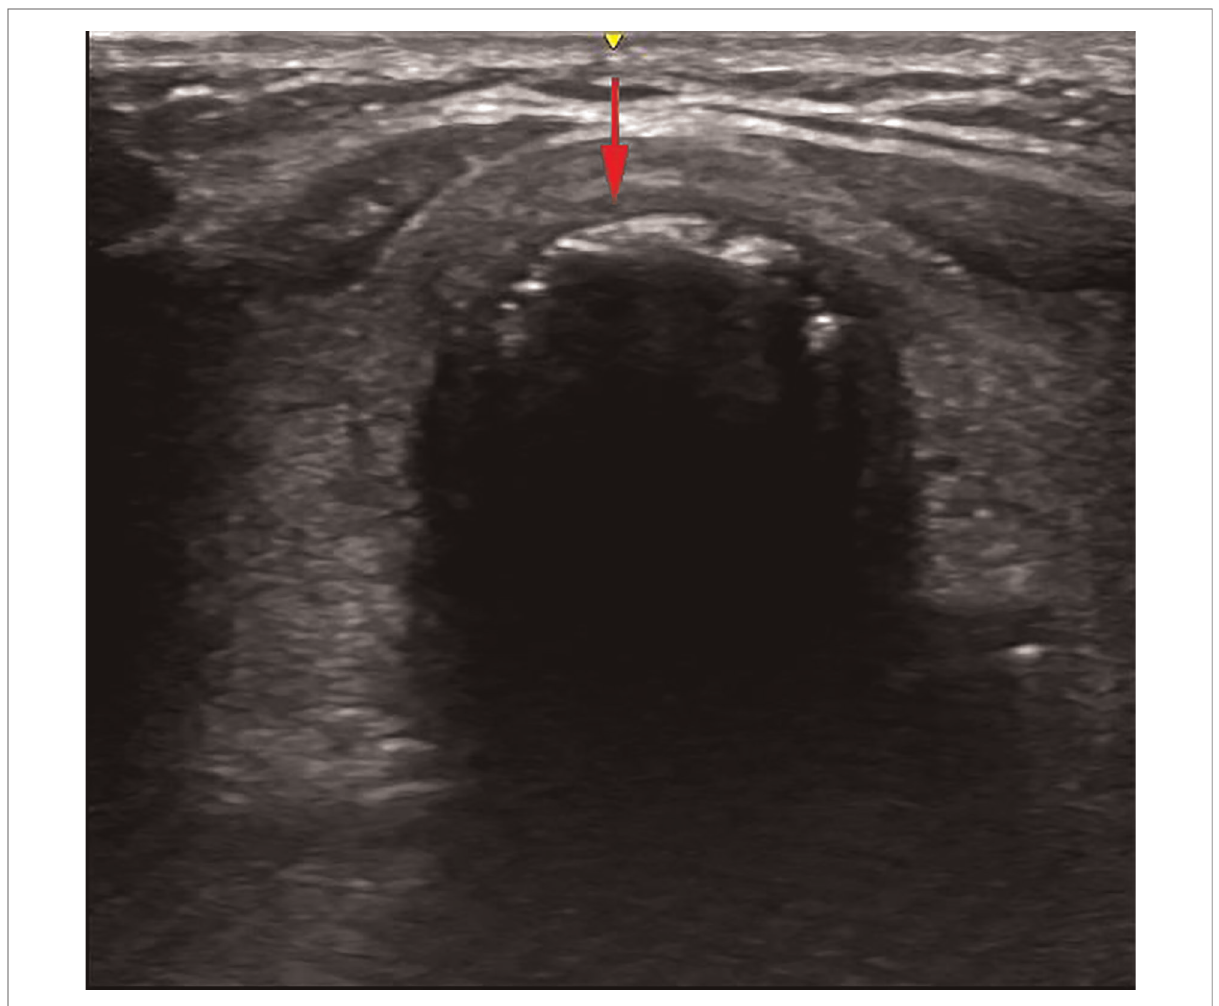
FIGURE 1 The inter-annular space between the second and third tracheal ring. The yellow and red arrows are the indication marks of the ultrasound probe and the direction of the puncture needle,